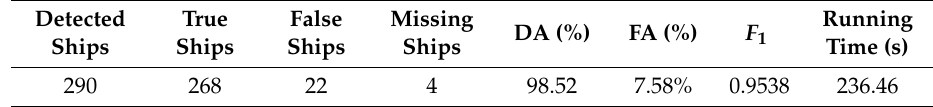
Table 6. The ship detection results validated with Automatic Identification System (AIS) for the Figure 10. The ship detection results of the Cosmo ‐ SkyMed imagery with the red rectangles Cosmo-SkyMed indicating the location of ships.